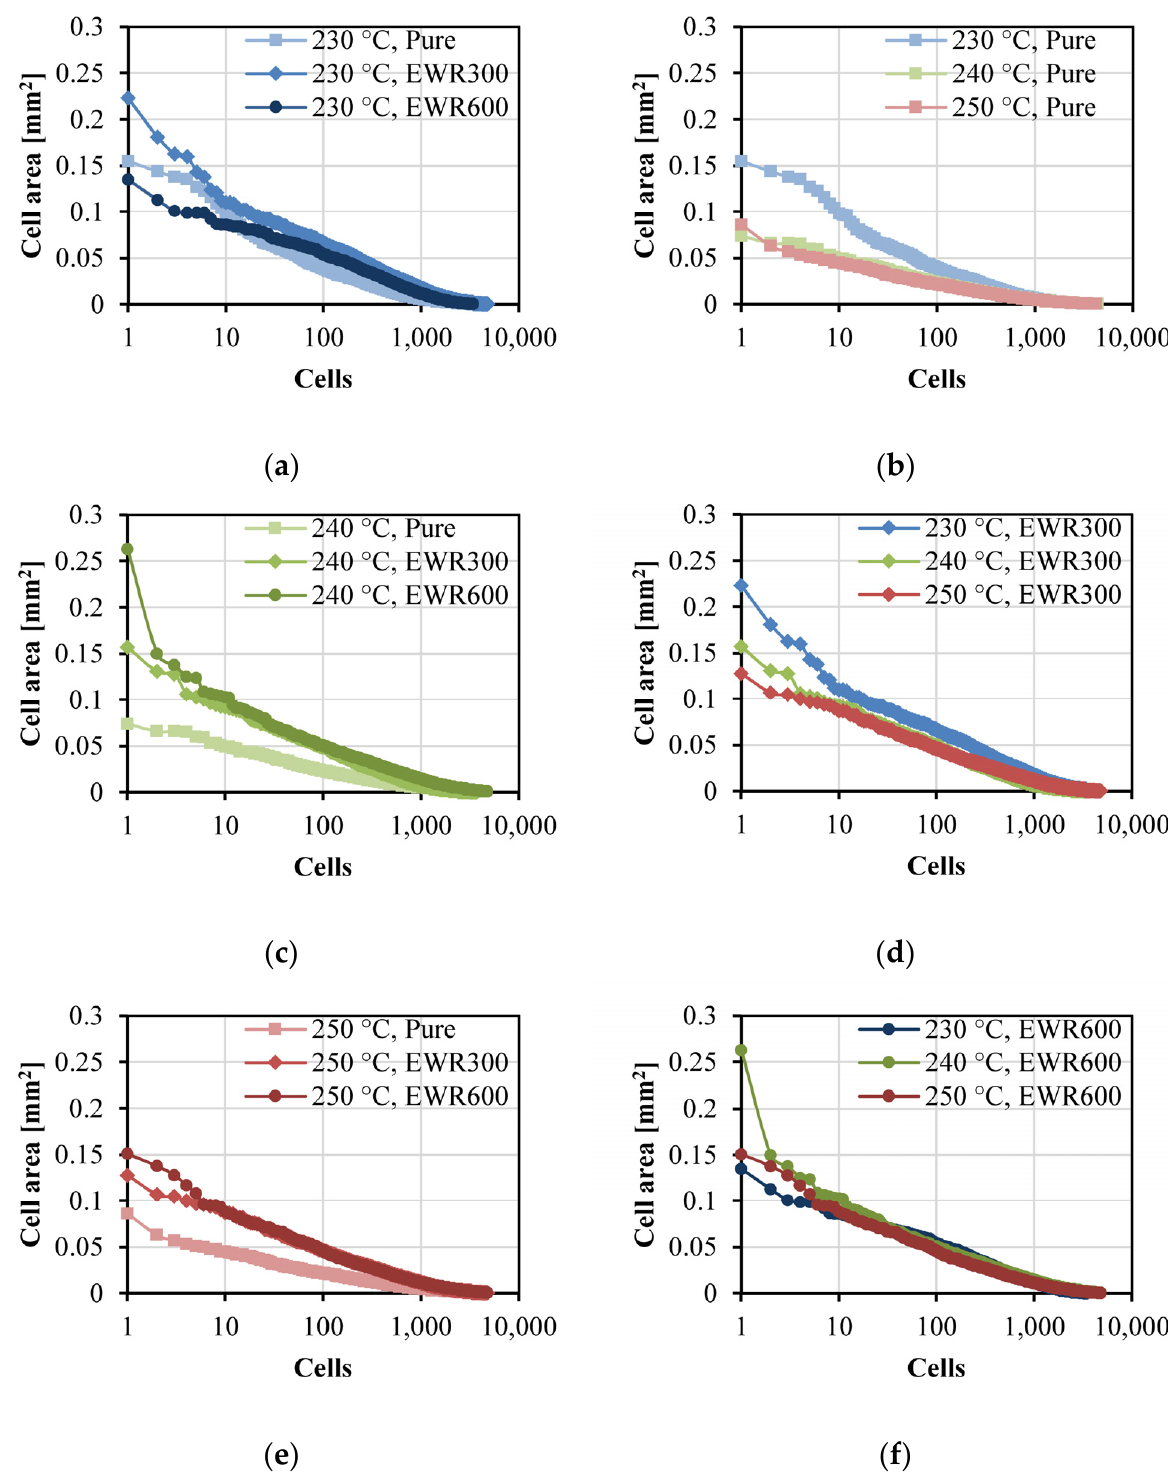
Figure 10. Cell areas (arranged in descending order) in the section area of the foamed samples. The curves for the comparison of the different samples are respectively shown in (a), (c), and (e), and the curves for the comparison of the samples at different temperatures are respectively shown in (b), (d), and (f).